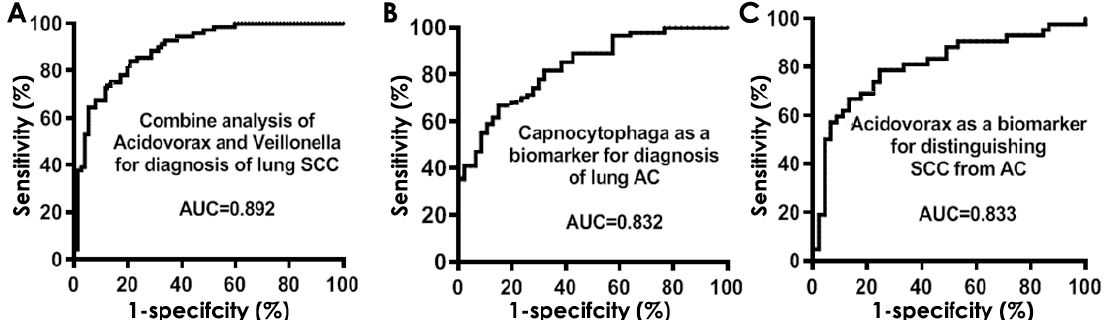
Figure 5. ROC curve analysis of abundances of bacterial genera in sputum of cohort 2. ( A ) The combined use of Acidovorax and Veillonella produced 0.89 AUC. ( B ) The use of Capnocytophaga as a sputum biomarker could detect lung AC with 0.83 AUC. C . The use of Acidovorax as a sputum biomarker had 0.83 AUC for differentiating between SCC and SC of the lungs.